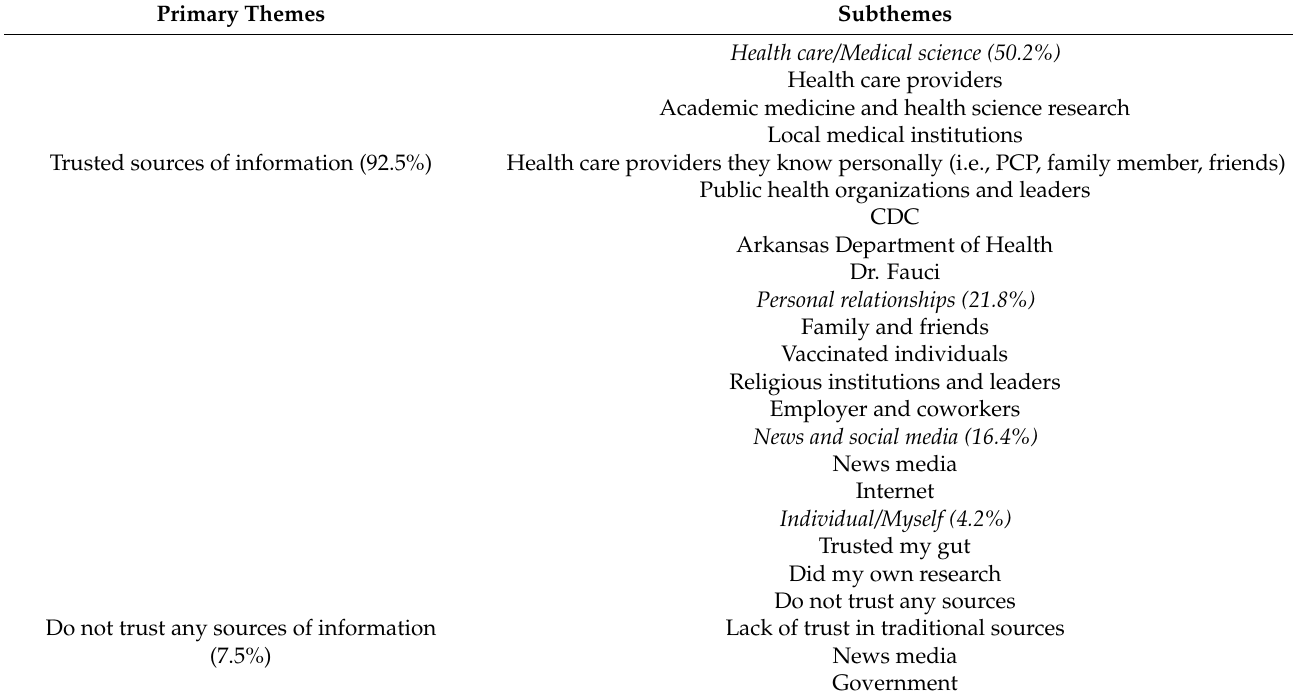
Table 3. Primary themes and emergent subthemes with definitions and